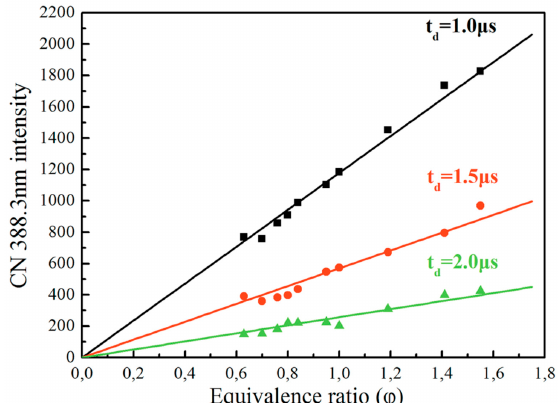
Figure 3. Intensity variation of the CN (388.3 nm) band as a function of the equivalence ratio at different delay times in a CH 4 /air flame [93]. (Reproduced from Kotzagianni M., and Couris S., Femtosecond laser induced breakdown for combustion diagnostics. Appl. Phys. Lett. 2012, 100 , 264104, with the permission of AIP Publishing).